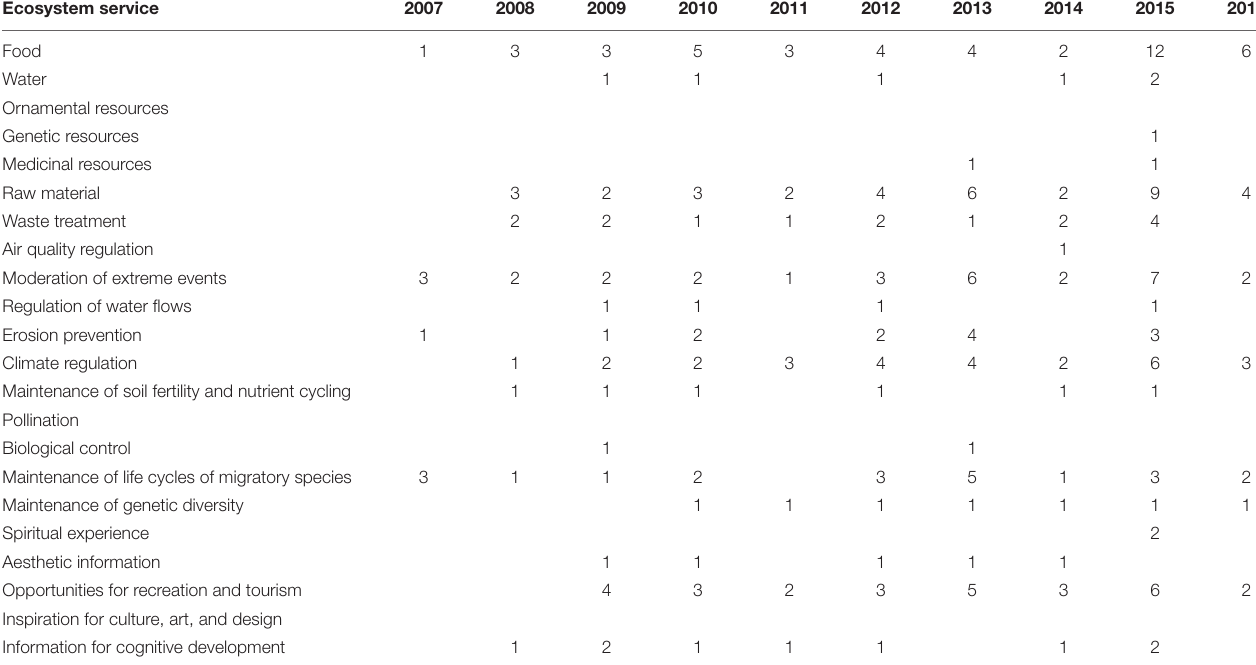
TABLE 5 | Frequency of how often mangrove ecosystem service values were published each year between 2007 and